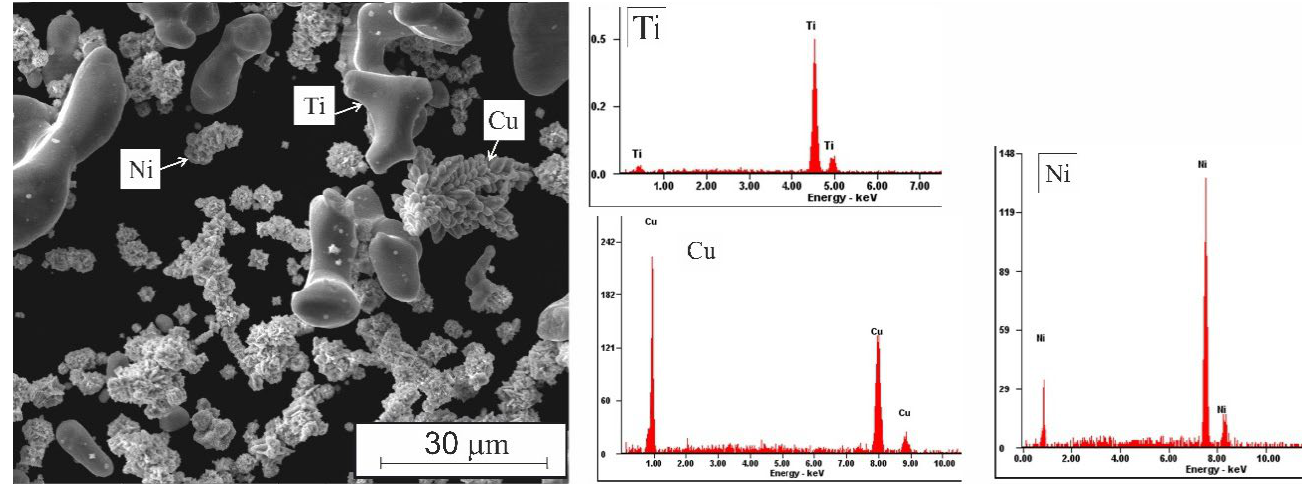
Figure 1. Macrostructure of Ti, Ni, and Cu powders with EDX spectra for each component. The initial Ti, Ni, and Cu powders were dried in a vacuum oven at a temperature of 350–360 K for 7 h; then they were mixed in a mixer for about 8 h. The resulting mixture was poured into a quartz flask, compacted for 30 min by the apparatus shaking method, and then placed in an electric furnace. When the synthesis starting temperature of 743 K was reached, SHS was initiated by a shortcut circuit at the opened end of the Ti-Ni-Cu powdered billet.